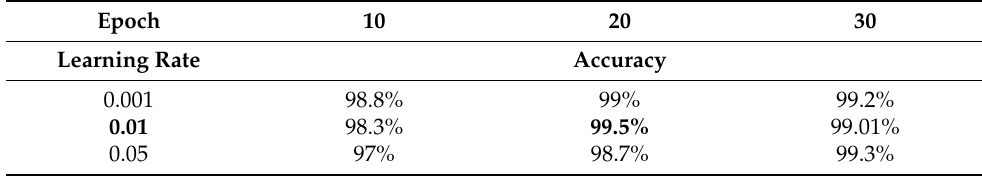
Table 3. Accuracy comparison with different epochs and learning